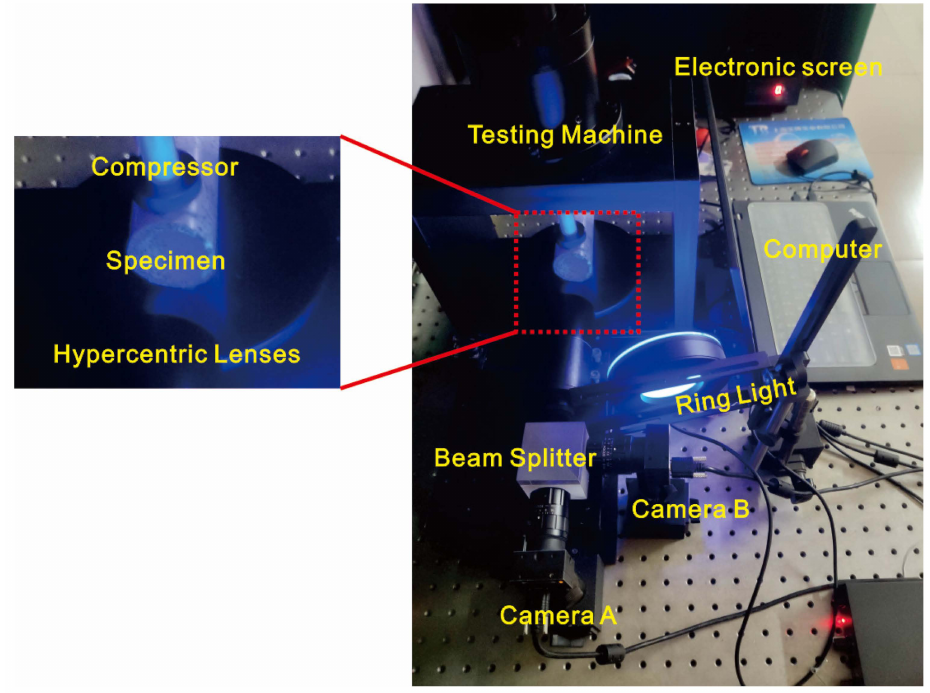
Figure 10. Pipeline compression